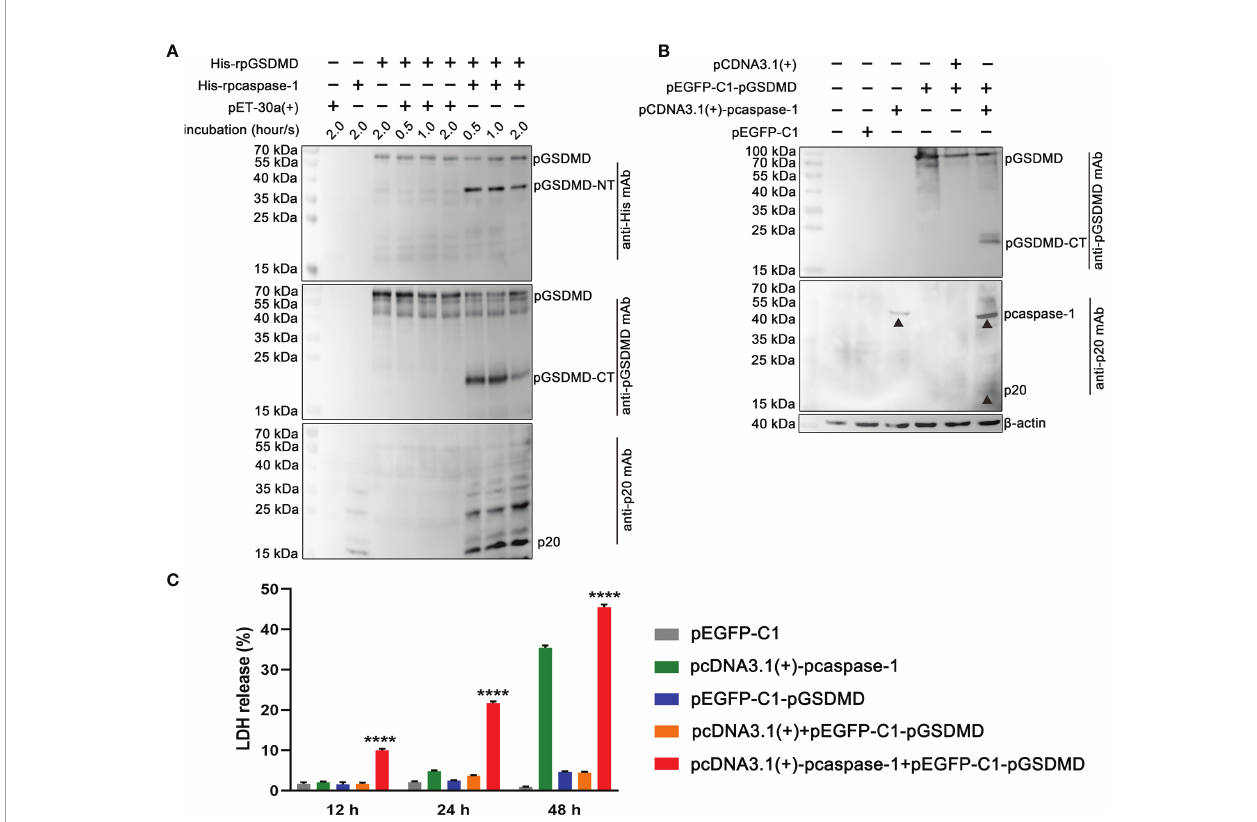
FIGURE 3 | In vitro cleavage of pGSDMD by pcaspase-1. (A) Cleavage of His-rpGSDMD by His-rpcaspase-1 in a cell-free system. Puri fi ed His-rpGSDMD was incubated with E. coli lysate containing His-rpcaspase-1 for 0.5, 1 and 2 h. The products were analyzed by western blot assays using mouse Anti-His mAb, mouse anti-rpGSDMD mAb and mouse anti-rpcaspase-1 p20 mAb. The mixtures of His-rpGSDMD and the cell lysate of pET30a(+) transformed E. coi l were used as controls. (B) Cleavage of pGSDMD by pcaspase-1 in HEK293 cells. HEK293 cells were transfected pEGFP-C1-pGSDMD and pcDNA3.1(+)-pcaspase-1 simultaneously. The Cells transfected with either of the two plasmids and the cells co-transfected with pEGFP-C1-pGSDMD and pcDNA3.1(+) severed as controls. 48 h after the transfection, whole cell lysates were analyzed by mouse anti-rpGSDMD mAb. (C) Determination of the cellular LDH release of the transfected cells. The supernatant of the transfected HEK293 cells was collected 12, 24 and 48 h after the transfection and the LDH release of the cells was measured. Values are the means of triplicates and shown as means ± SD. **** p < 0.0001. GSDMD, full-length GSDMD; GSDMD-NT, N-terminal cleavage product of GSDMD; GSDMD-CT, C-terminal cleavage product of GSDMD; p20, mature